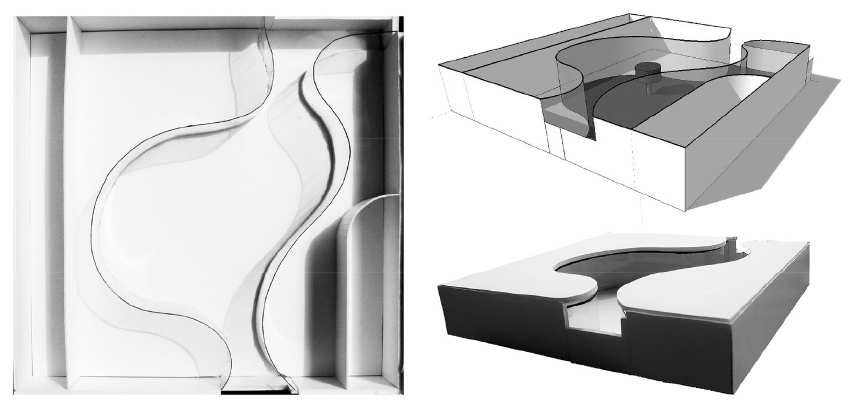
Figure 1. The space for the quince. Student: Sergio Tejero (2009)